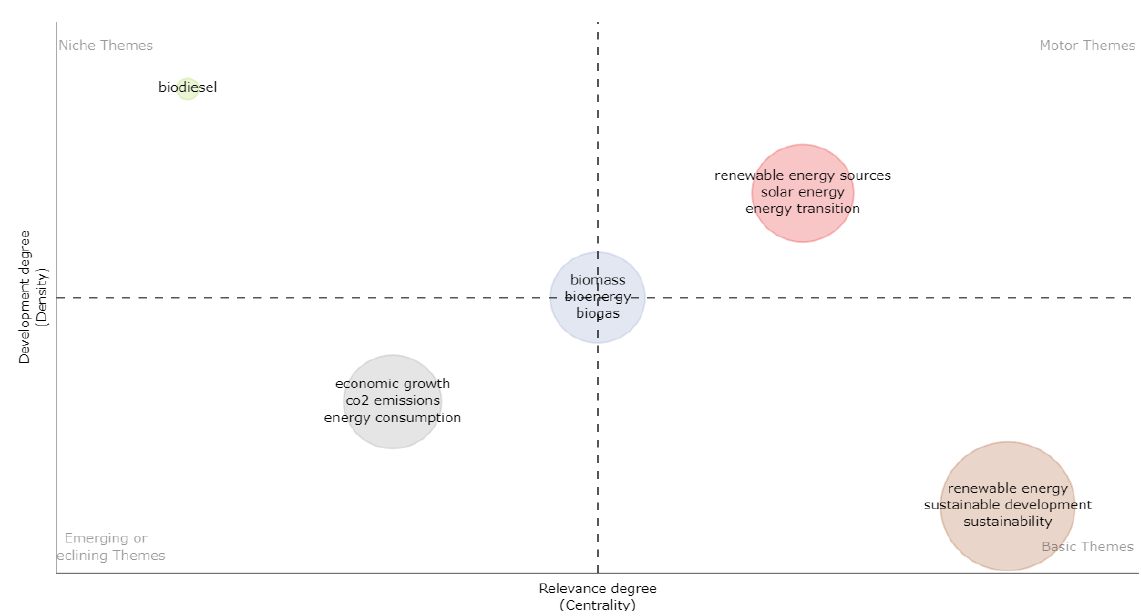
Figure 9. Thematic map. The density dimension reflects intra-cluster growth, while the centrality dimension represents the relevance or significance of a subject inside a particular area and the intensity of between-cluster links [120]. It consists of four quadrants, each of which represents a distinct characteristic of the themes